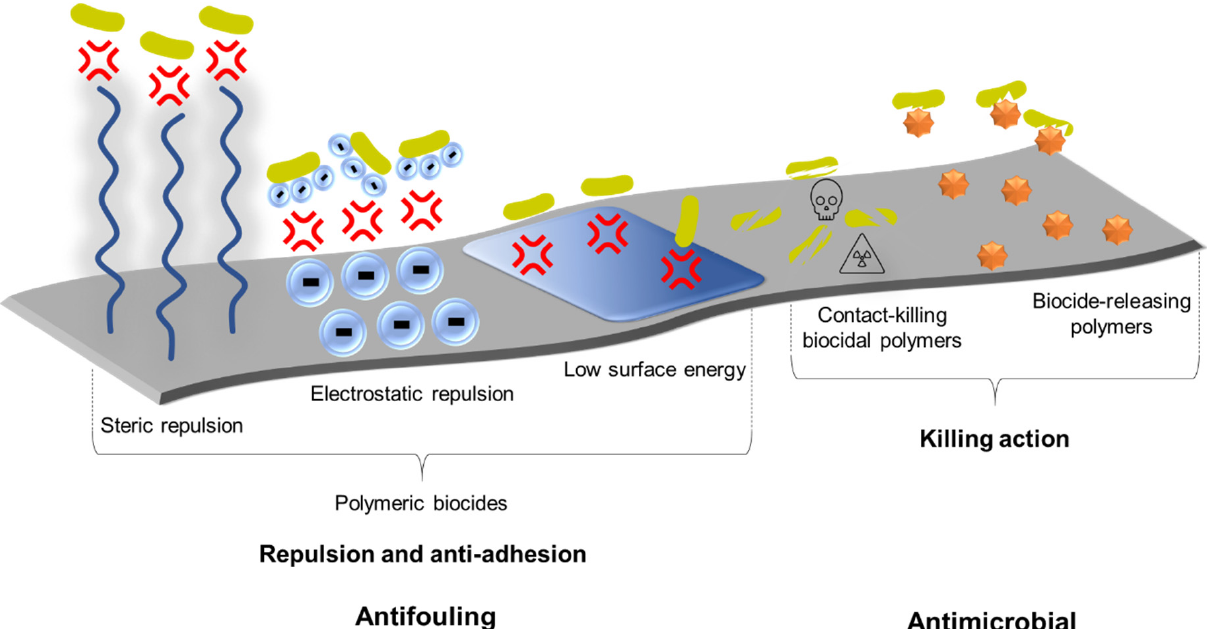
Figure 5. Illustration of the mechanisms of action of the different classes of antimicrobial polymers: polymeric biocides, biocidal polymers and biocide-releasing polymers.